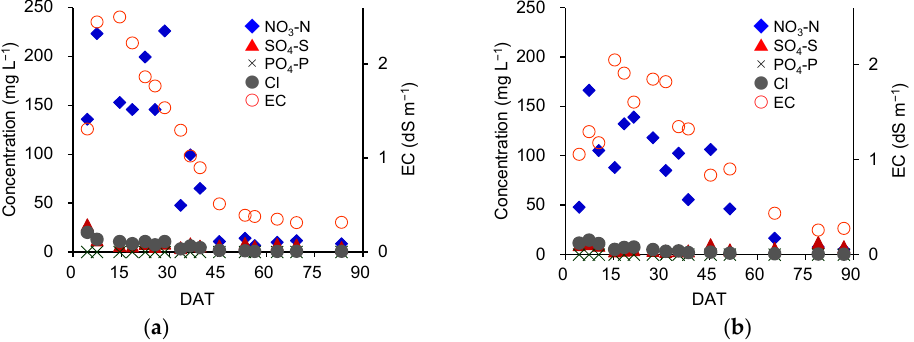
Figure 3. Electrical conductivity (EC) and anion concentrations of soil solutions in the fertilized plot during the growing seasons of Trial 1 ( a ) and Trial 2 ( b ). Each plot represents the mean of four replicates.